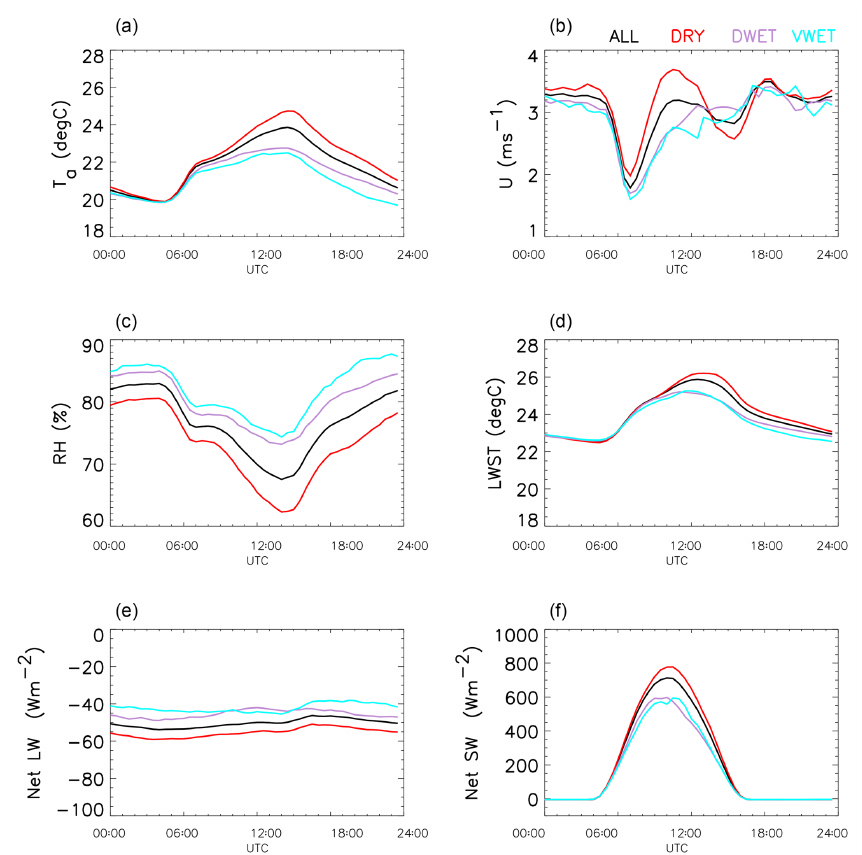
Figure 10. Mean diurnal cycles of (a) air temperature ( T a , ◦ C), (b) wind speed ( U , ms − 1 ), (c) relative humidity (RH, %), (d) lake surface temperature (LWST, ◦ C) from the upwelling longwave irradiance, assuming an emissivity of 0.99, (e) net longwave irradiance (net LW, Wm − 2 ) and (f) net shortwave irradiance (net SW, Wm − 2 ). The input data are those from the 4 years 2013–2016 of the campaign, to represent all seasons equally. The colours correspond to diurnal cycles averaged over ALL days (black), DRY days (red), DWET days (purple) and VWET days (cyan).